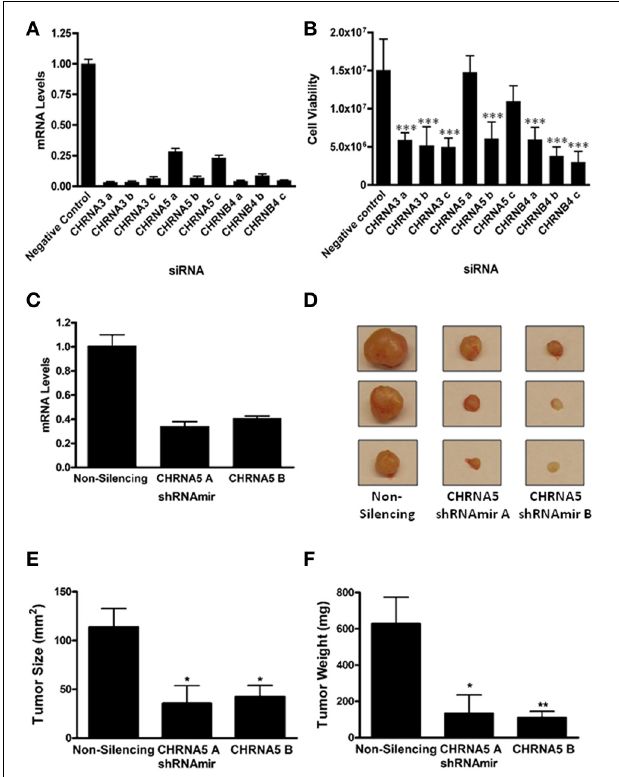
FIGURE 1 | CHRNA3 , CHRNA5 , and CHRNB4 depletion decreases SCLC cell growth. DMS-53 cells were treated with three distinct CHRNA3 , CHRNA5 , and CHRNB4 siRNAs or a negative control siRNA (Applied Biosystems). (A) Quantitative RT-PCR was performed to determine mRNA levels upon knockdown. (B) A bioluminescence-based cell viability assay was performed to determine the effect of siRNA treatment on SCLC cell viability ( ∗∗∗ p < 0 . 001, ANOVA, Tukey post-hoc test). (C) CHRNA5 mRNA levels in DMS-53 cells stably expressing a non-silencing shRNAmir or two CHRNA5 shRNAmirs (Open Biosystems). shRNAmirs were transduced into DMS-53 cells using a lentiviral delivery system for stable expression (Open Biosystems Trans-Lentiral Packaging System). (D) DMS-53 cells stably expressing a non-silencing shRNAmir or two CHRNA5 shRNAmirs were subcutaneously injected into the hind flanks of athymic nude mice. Tumors were harvested after 2 months (representative images shown). Tumor size (E) and weight (F) were significantly lower in samples treated with CHRNA5 shRNAmirs vs the non-silencing control ( ∗ p < 0 . 05; ∗∗ p < 0 . 01, ANOVA, Tukey post-hoc test).